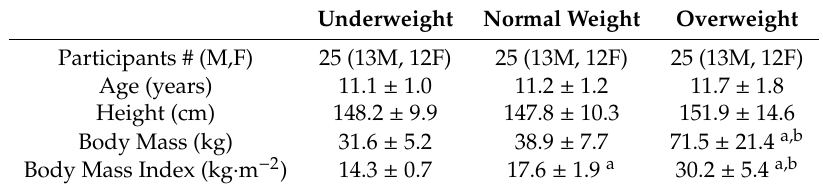
Table 1. Demographic and anthropometric characteristics of participants. Values are expressed as mean ±